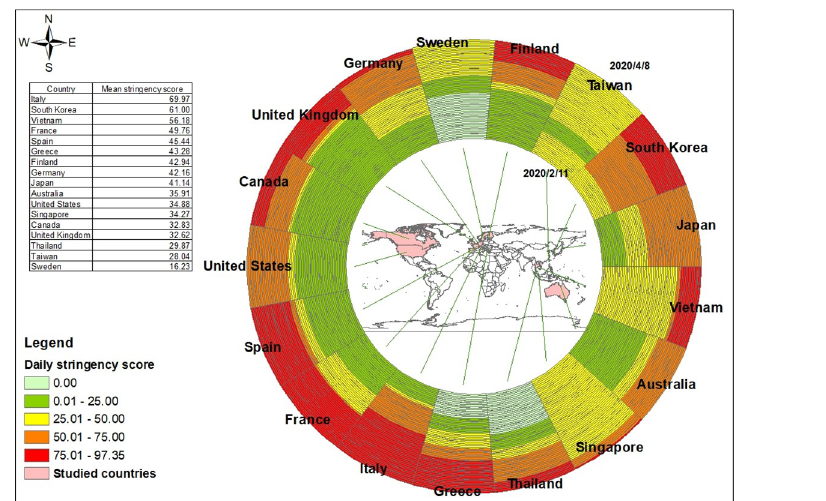
Fig 3. Ring map of daily stringency score from Feb. 11 to Apr. 8, 2020.